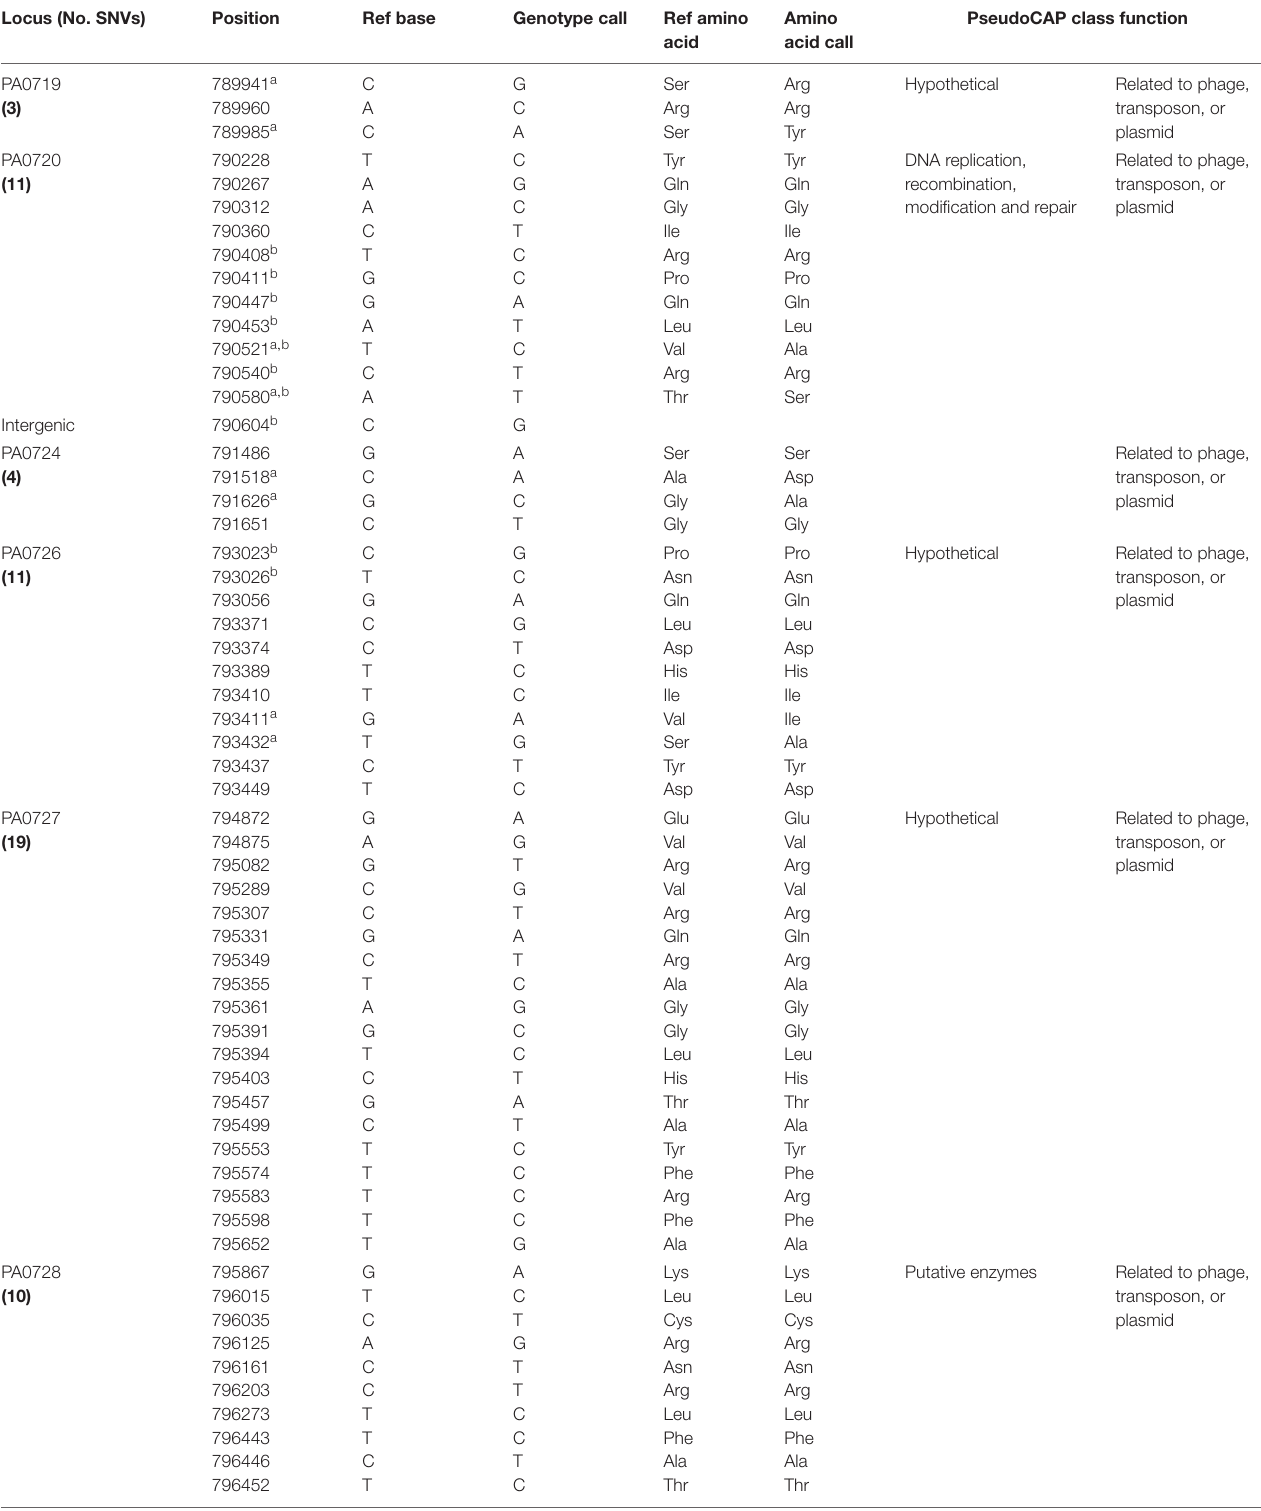
TABLE 3 | Single nucleotide variations unique to F1 strain compared to the wild-type. Locus (No.